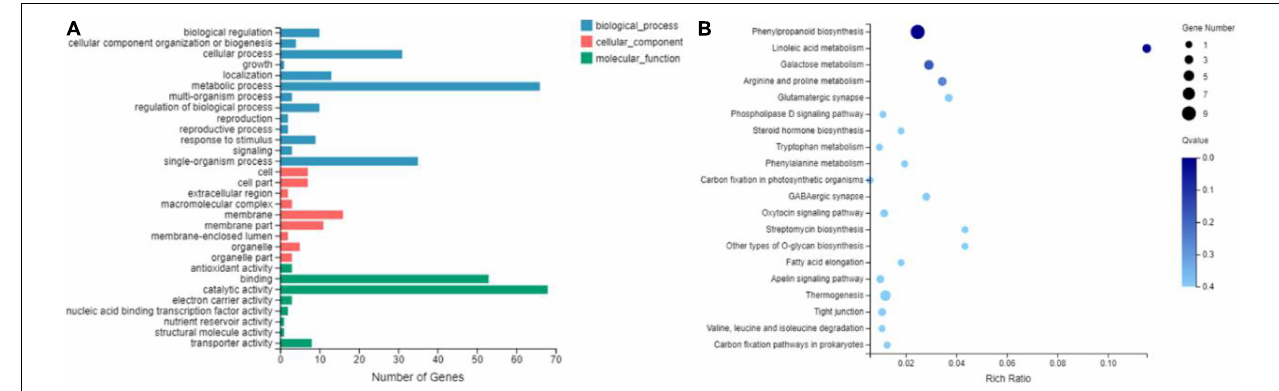
FIGURE 6 | Gene ontology classification (A) and enriched Kyoto Encyclopedia of Genes and Genome pathway scatterplots (B) of DEGs shared by mutant bk5 vs. WT. TABLE 2 | Summary of sequencing and mapping from brittleness bulk (B694) and non-brittleness bulk (B695) for BSA-seq analysis. Sample